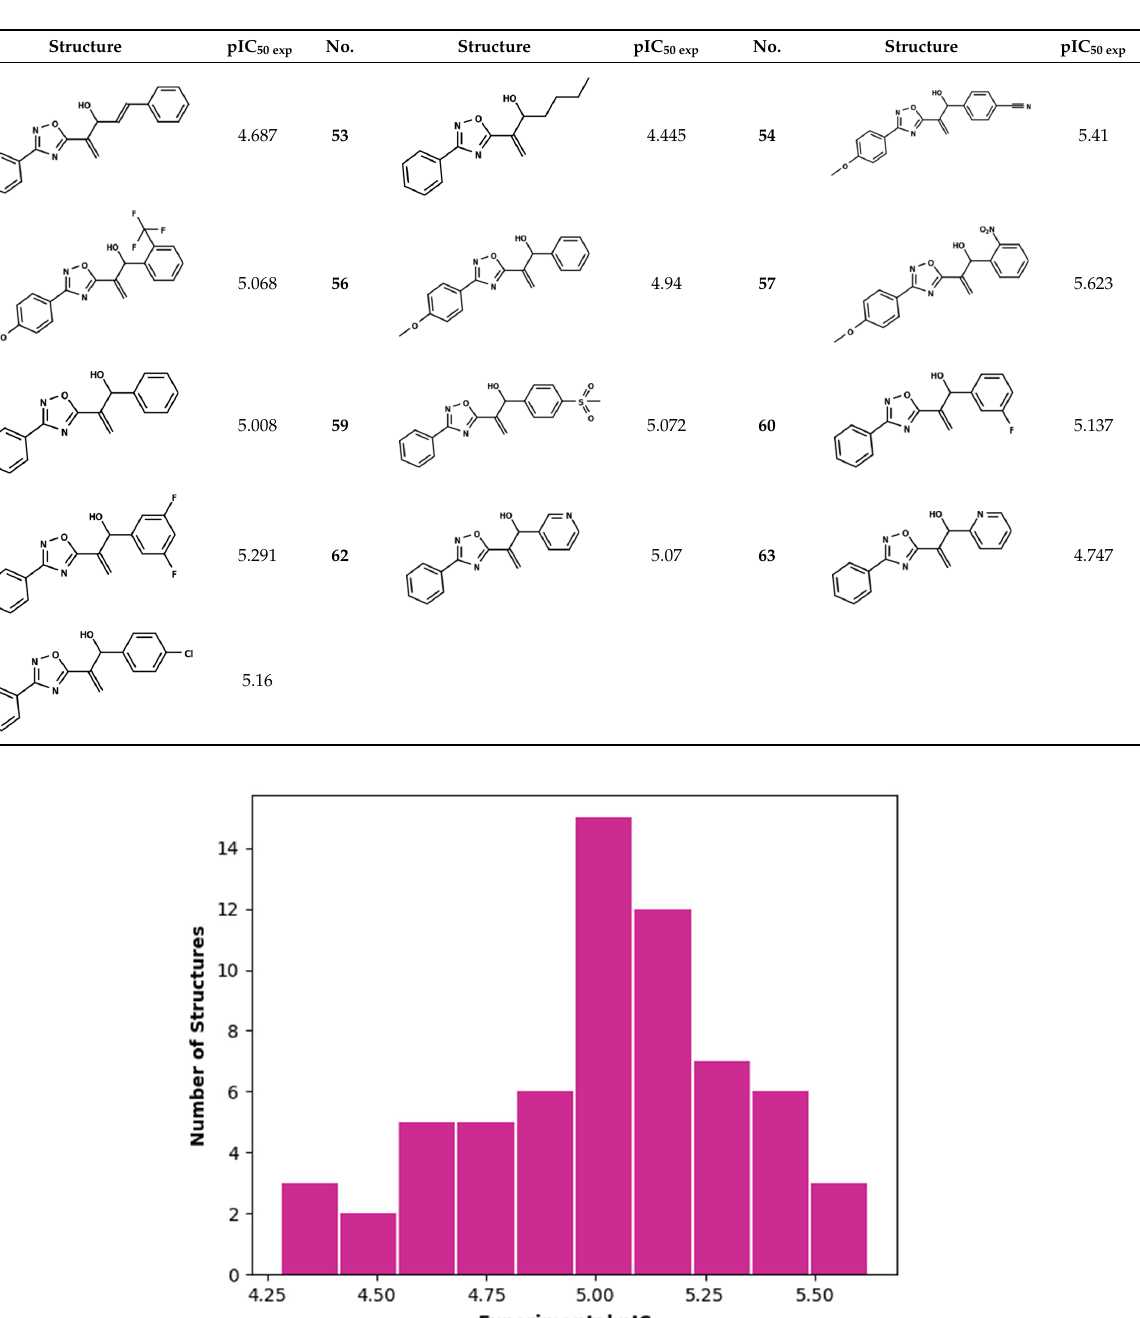
Figure 7. Histogram for the distribution of the experimental pIC 50 values over the entire compound set used in the QSAR studies.